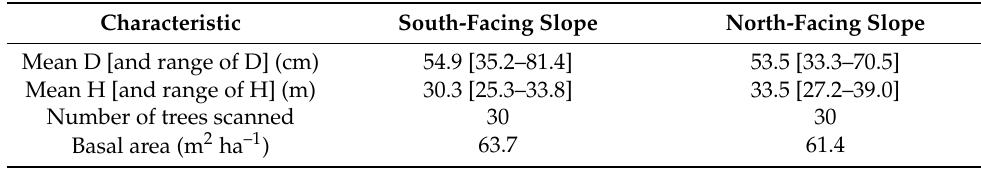
Table 2. The characteristics of the scanned sample trees.